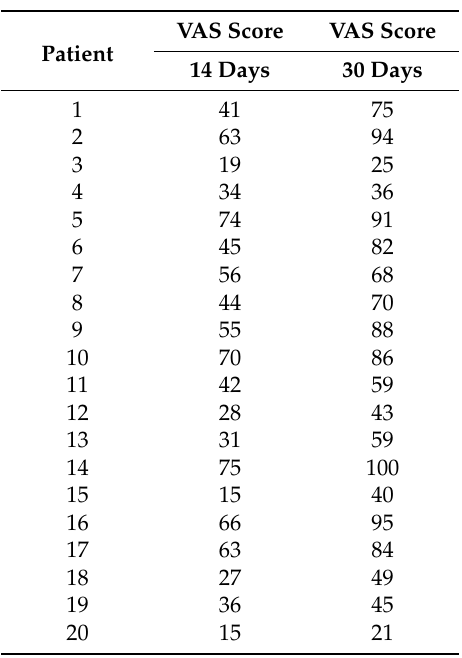
Table 2. Patient’s satisfaction level assessed by visual analogue scale (VAS) score at 14 days and 30 days